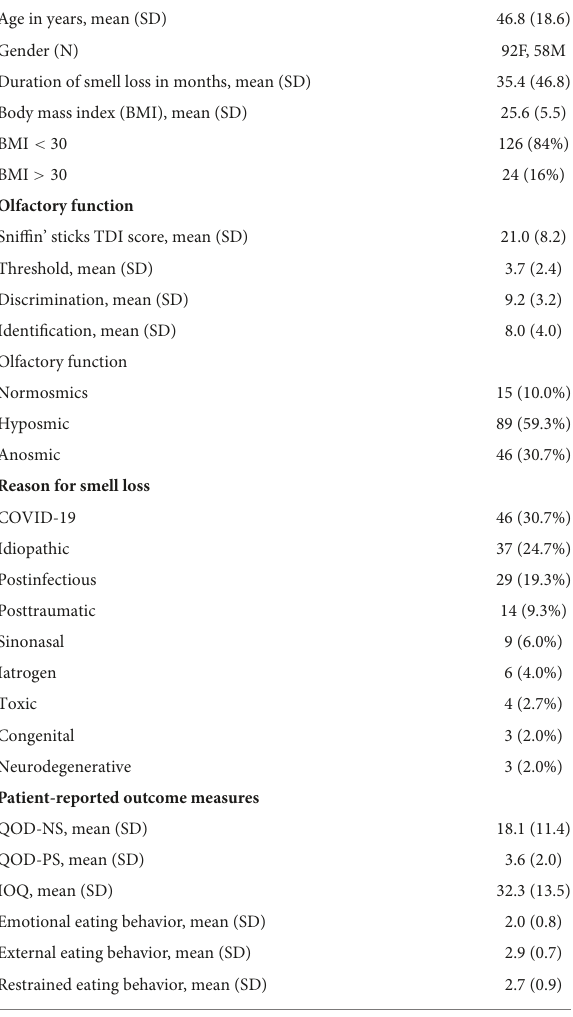
TABLE 1 Demographics and clinical characteristics.